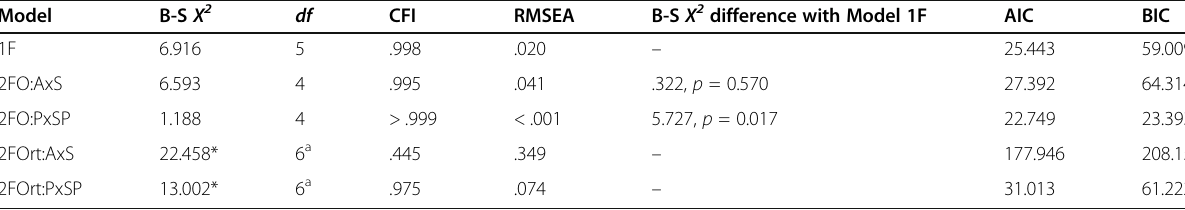
Table 2 Fit indices for models of the structure of phonological awareness tasks